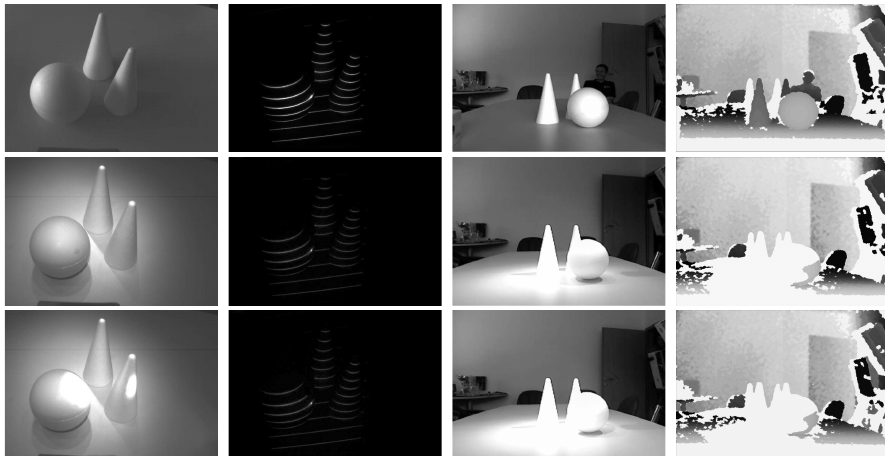
Figure 10. Qualitative examples of the performance of the developed acquisition procedure under various ambient lighting conditions. The first column shows a sample scene in different illumination conditions (from top to bottom ): no additional illumination ( top ), with room lights on ( middle ) and with room lights on and a flashlight directed at the scene ( bottom ). The second column of images shows the distortion maps captured with the ATRIS sensor for the different illumination conditions. The third column depicts the same scene captured at the same time instance as the images in the first column, but with the Kinect sensor (v1). The last column presents the corresponding depth images generated by the Kinect sensor. Here, white areas indicate that no depth information could be